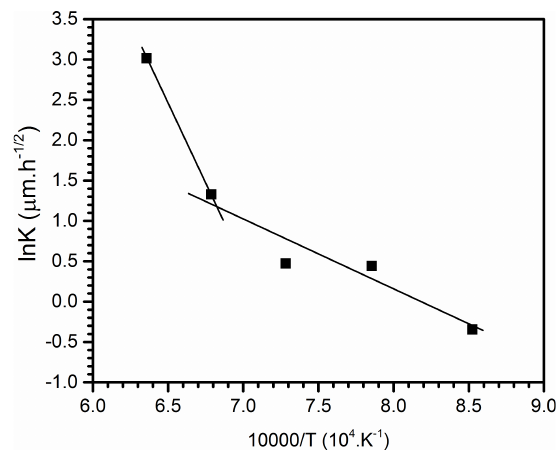
Figure 7: Arrhenius plots between scale growth rate constant and 1/T indicating two different regions of oxide scale growth.